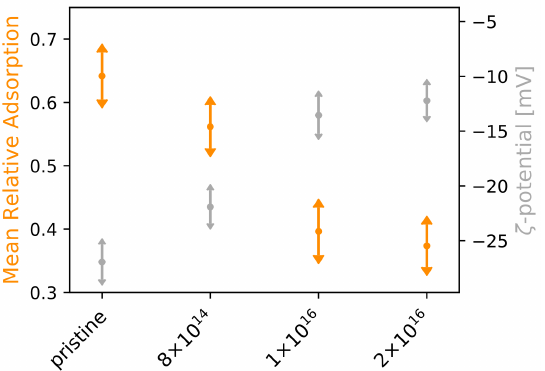
Figure 2. ζ -potential and mean relative laminin adsorption for examined TNSs. Protein adsorption experiments on TNSs were performed for four laminin concentrations (0.1, 0.5, 1.0, and 1.5 µ g · cm − 2 ). Ion fluences are given in ions · cm − 2